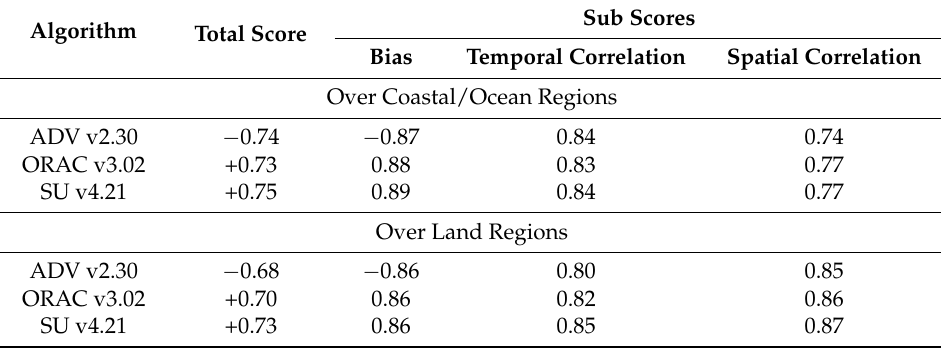
Table 6. Evaluation scores for the three ATSR AOD datasets at 550 nm based on daily L3 “common data point” matches to AERONET data for the year 2008. Total scores are listed in column 2 and the underlying sub-scores for bias, temporal correlation and spatial correlation are presented in columns